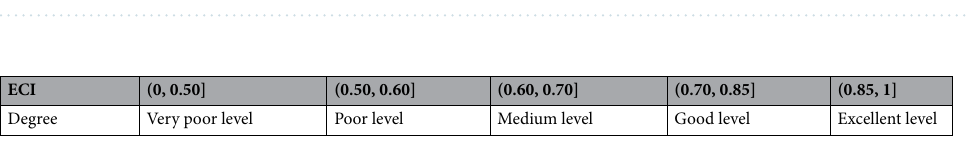
Table 2. Standard for coupling degree level. CI the coupling index.